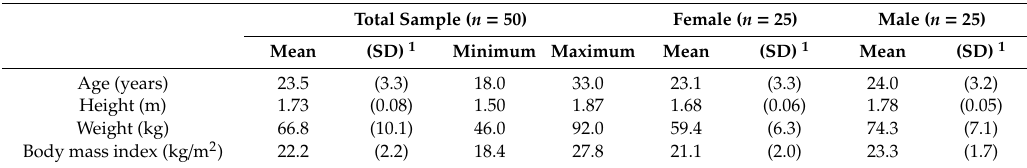
Table 1. Baseline characteristics of the study participants for the total sample and by